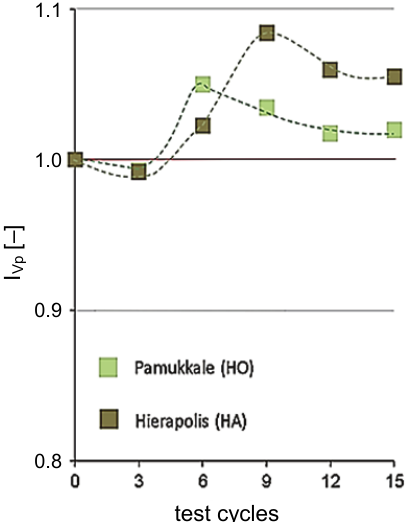
test Fig. 10. Advancement of deterioration reflected in the ultrasonic waves index I Vp after the impact of salt crystallization